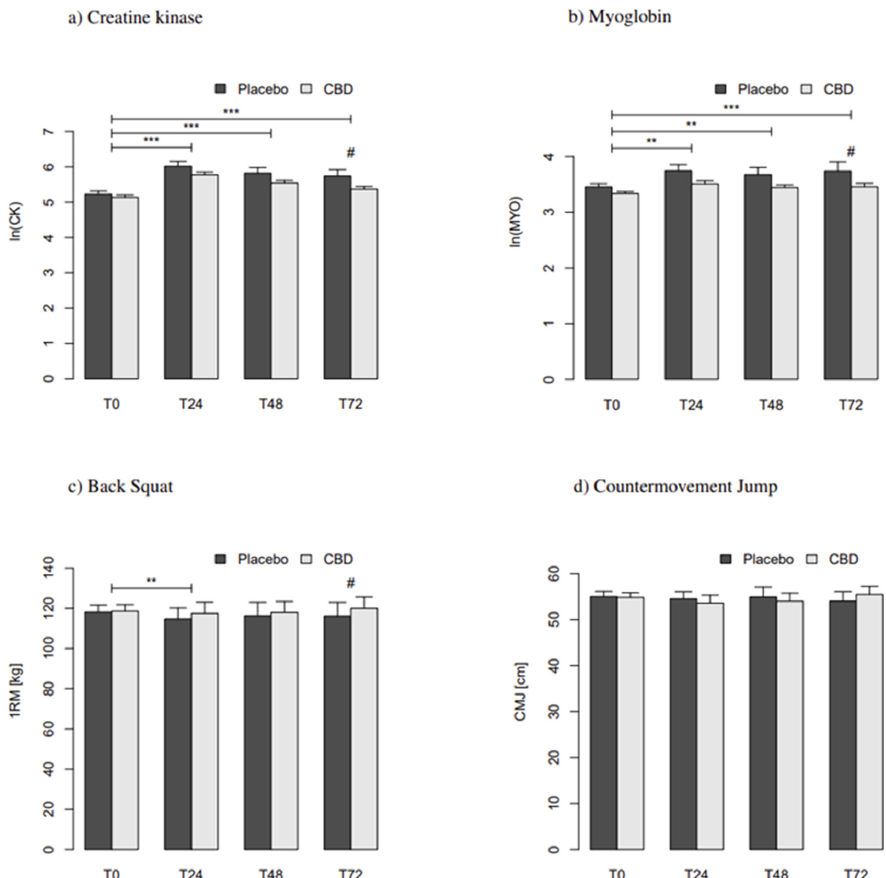
Figure 2. The mean ± SE for both groups at all time points. ( a ) Skeletal Muscle Specific Creatine Kinase. ( b ) Myoglo- Figure 2. Barplots of the means ± SEM for the modeled parameters. ( a ) Skeletal Muscle Specific Creatine Kinase, bin. ( c ) Back Squat, ( d ) Countermovement Jump. *** indicates a significant difference over time with p < 0.001; ( b ) Myoglobin, ( c ) Back Squat, ( d ) Countermovement Jump. T0 through T24: Time, where figures indicate levels [h]. ** = p < 0.01. Indicates a significant difference between groups at given time point with # = p < 0.05. Asterisks indicate significant differences in time. p < 0.01, **; p < 0.001, ***. Hash indicates difference between groups at indicated level of time (#: p <